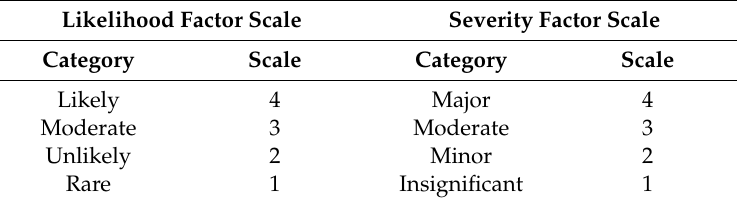
Table 2. Scales for likelihood and severity factors.